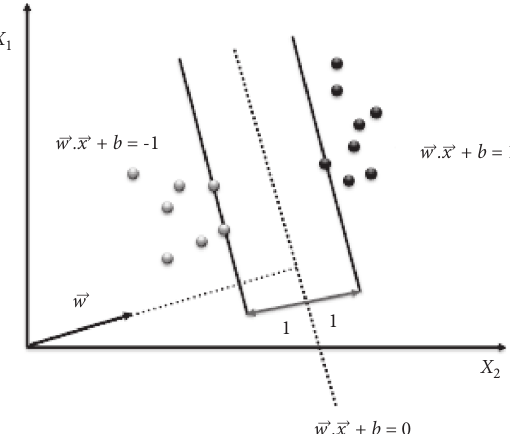
Figure 2: Illustrating the SVM classes with their question types.